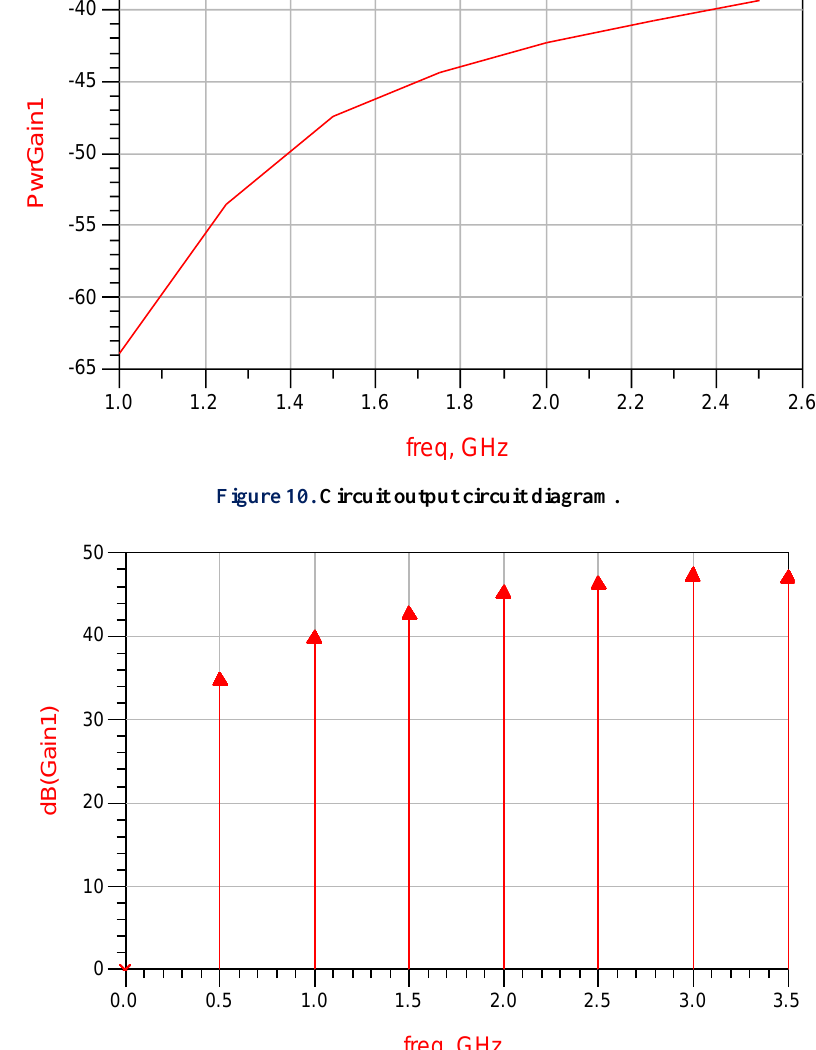
Figure 11. Gain diagram